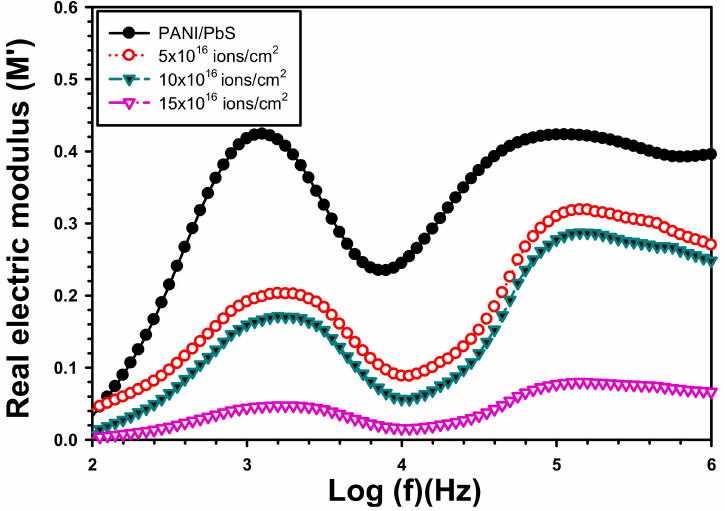
Figure 8. Variation of the electrical modulus ε (cid:48) with frequency for pristine and treated PANI/PbS